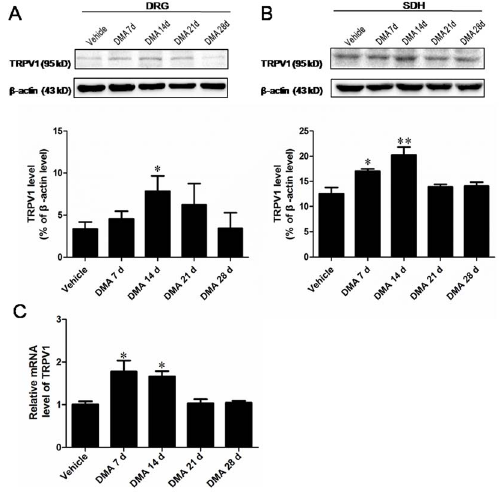
Figure 2. Expression tendency of TRPV1 in DRG and SDH with the progression of DMA. A and B , Western blot assay of TRPV1 in extracts of DRG ( A ) and SDH ( B ). Upper lane, typical blotting band. Lower lane, the densitometric analysis reveals the significant increase of TRPV1 protein in DRG on DMA 14 d and increase of TRPV1 in SDH on DMA 7 d and 14 d. C , Quantitative RT-PCR assay of TRPV1 expression at mRNA level revealing the marked increase of TRPV1 transcripts in DRG on DMA 7 d and 14 d. Data are represented as the mean + S.E.M (n=6).* P , 0.05, ** P , 0.01 vs . vehicle control.